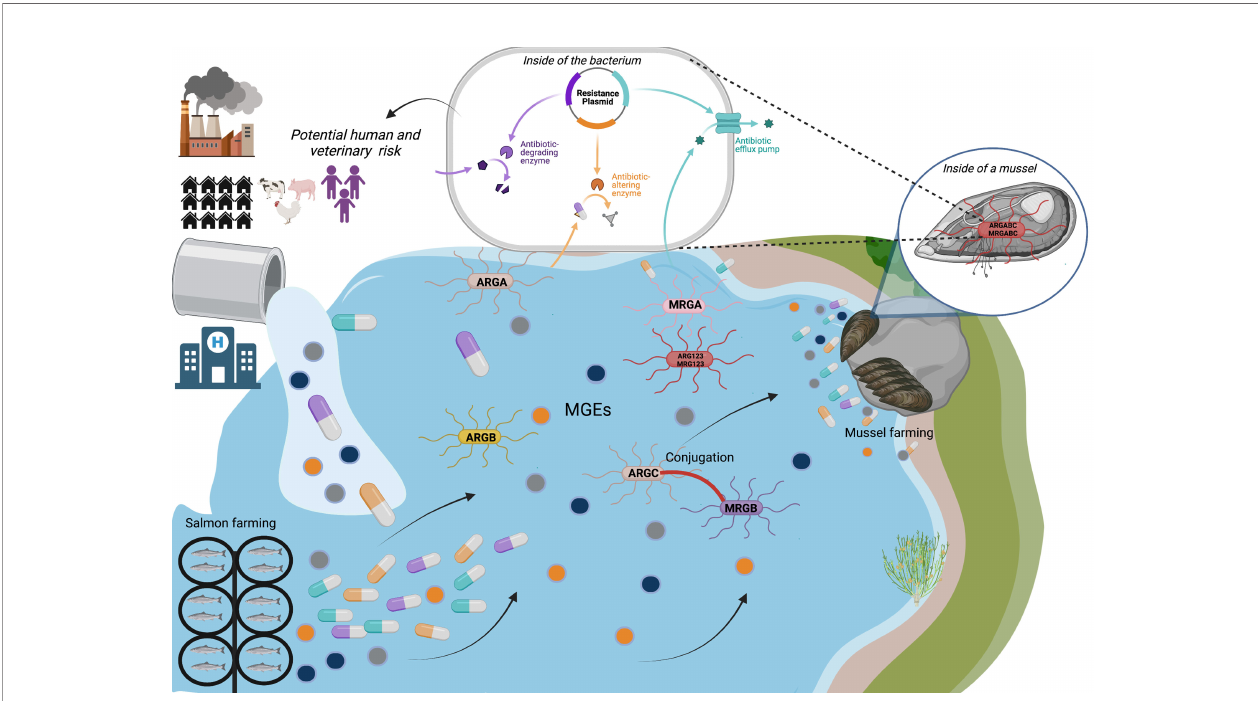
FIGURE 7 | Possible risk of mussel ’ s cultivation in Los Lagos Region. Discharge of antibiotics and heavy metals from diverse industries in Los Lagos Region implies a possible risk to humans and animals, which consume mollusks raised in these areas. The presence of antibiotics and heavy metals could favor co-selection, co- resistance and/or cross-resistance mechanisms between bacteria with mobile genetics elements (MGEs) and different antimicrobial resistance genes (ARGA, ARGB, ARGC) or different metal resistance genes (MRGA, MRGB, MRGC) inside the bacterial components of the mussels ’ microbiota, rising the risk of antimicrobial- resistance genes transfer to